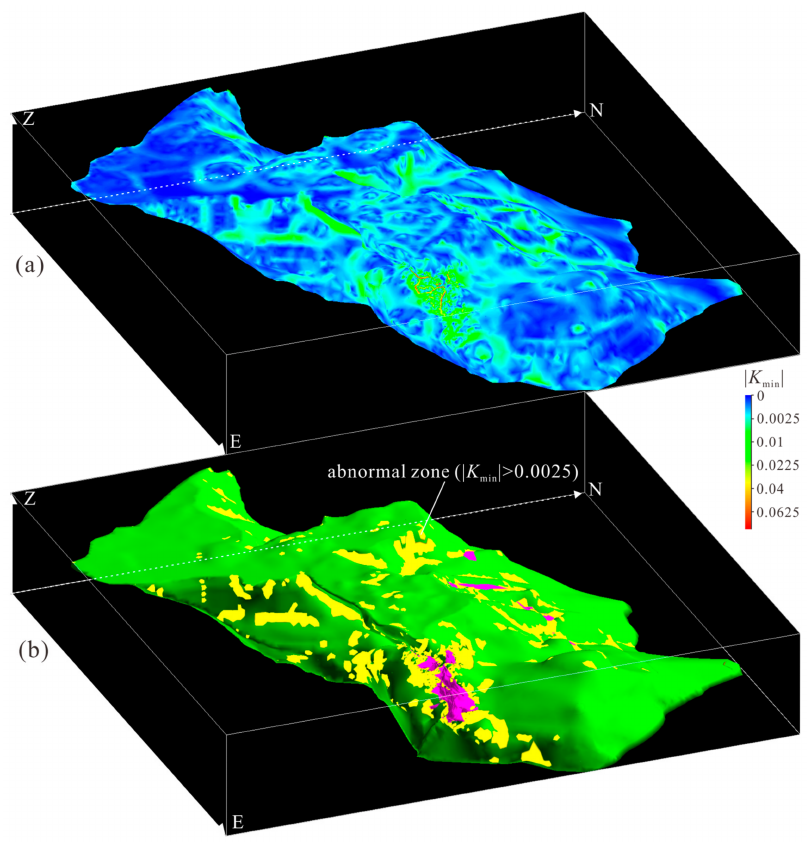
Figure 5. ( a ) Minimum principal curvature analysis results of the intrusion surface; ( b ) the chosen abnormal zones (| K min | >0.0025) and their spatial association with orebodies.